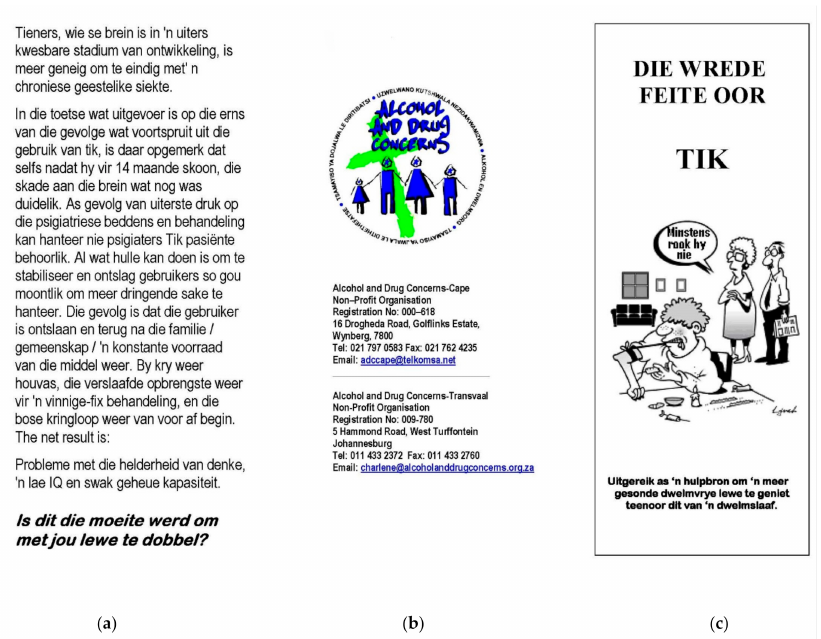
Figure 2. Example page of the existing brochure used in this study (Afrikaans version; there was no English version). Summary of the content in panel ( a ): This section discusses the dan- gers of MA use. Summary of the content in panel ( b ): This section reflects the logo and con- tact details of the non-governmental organization who developed the brochure. Summary of the content in panel ( c ): This section shows the cover page. Translation of the text above the car- toon/image: ‘The cruel facts about